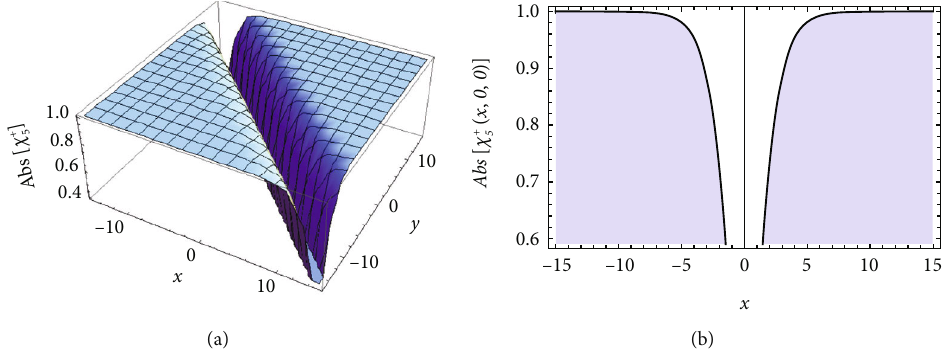
x , y , t Þj with the parameters λ = 1 , v = 1 , v 5 ð